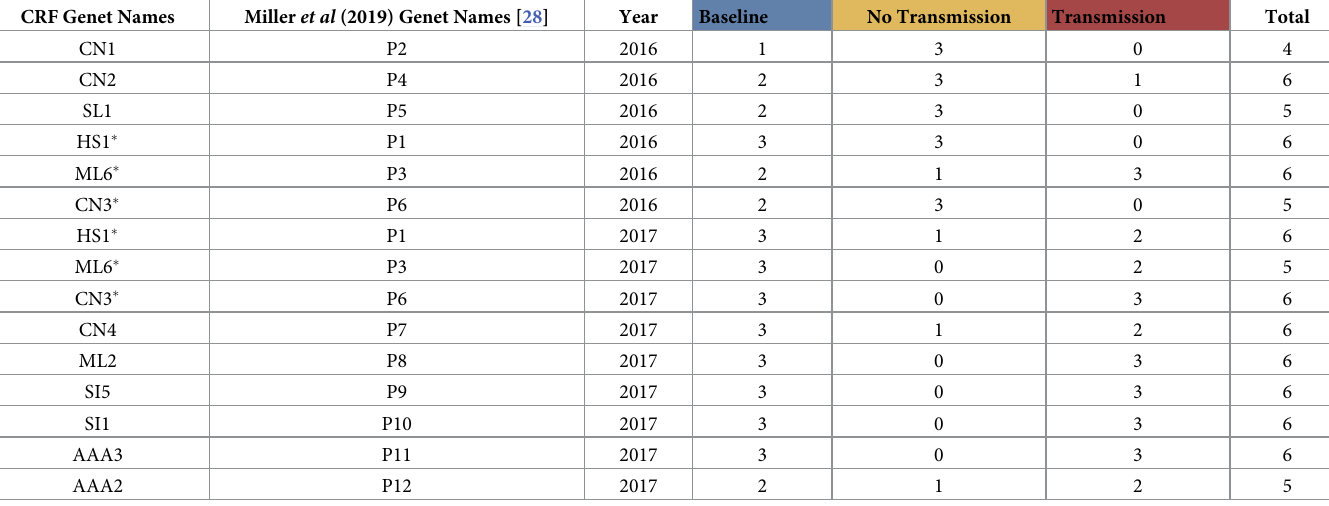
Table 1. Breakdown of genets and fragments sequenced for gene expression analysis. CRF Genet